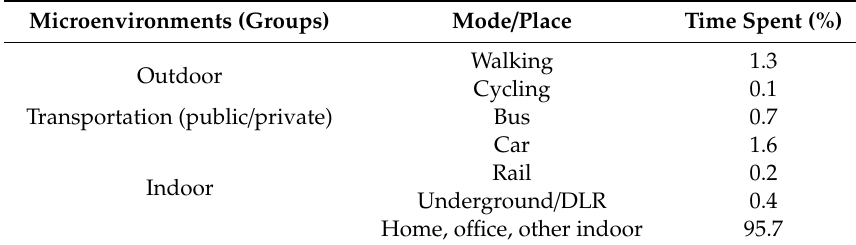
Table 3. Summary table of the time–activity